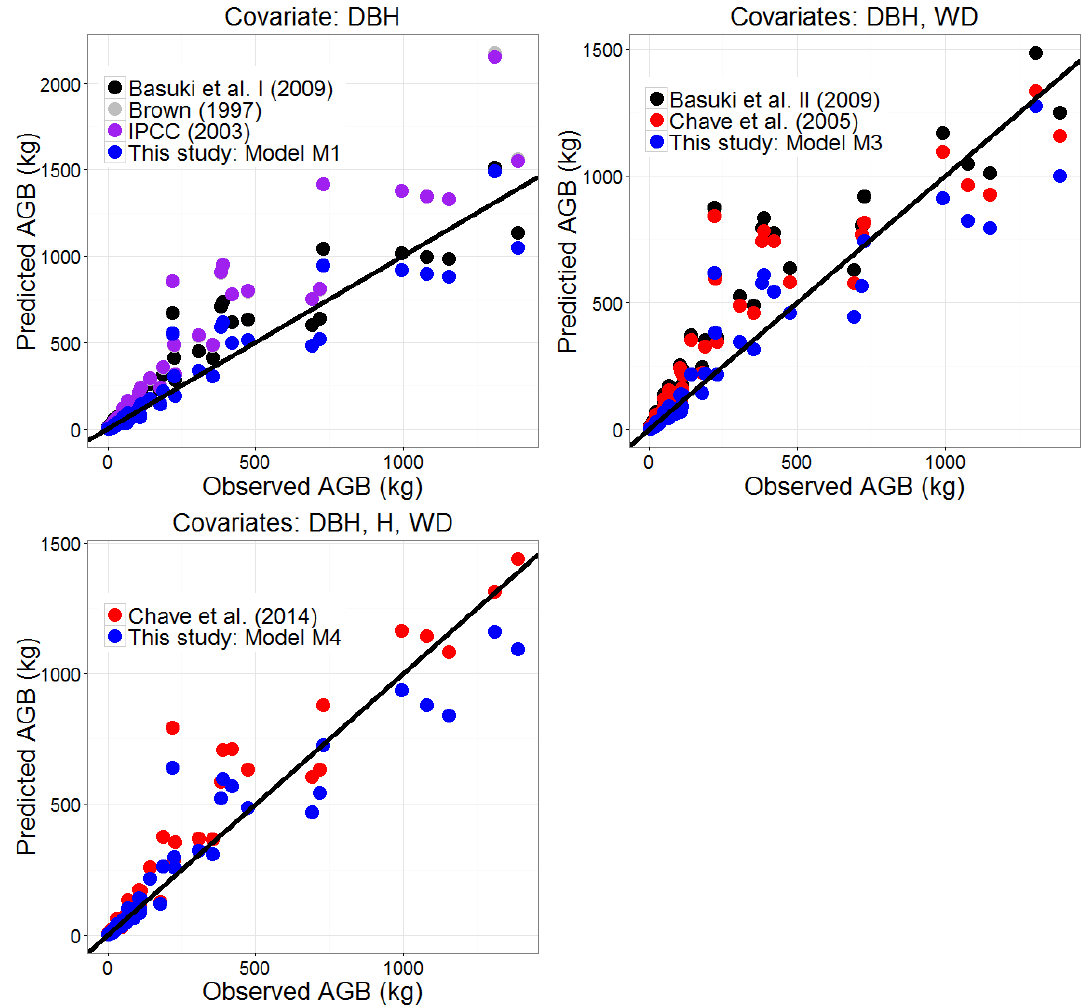
Figure 6. Observed vs. predicted AGB obtained from the mixed ‐ species equations developed in this study, pantropical equations, and equations for dipterocarp forest of